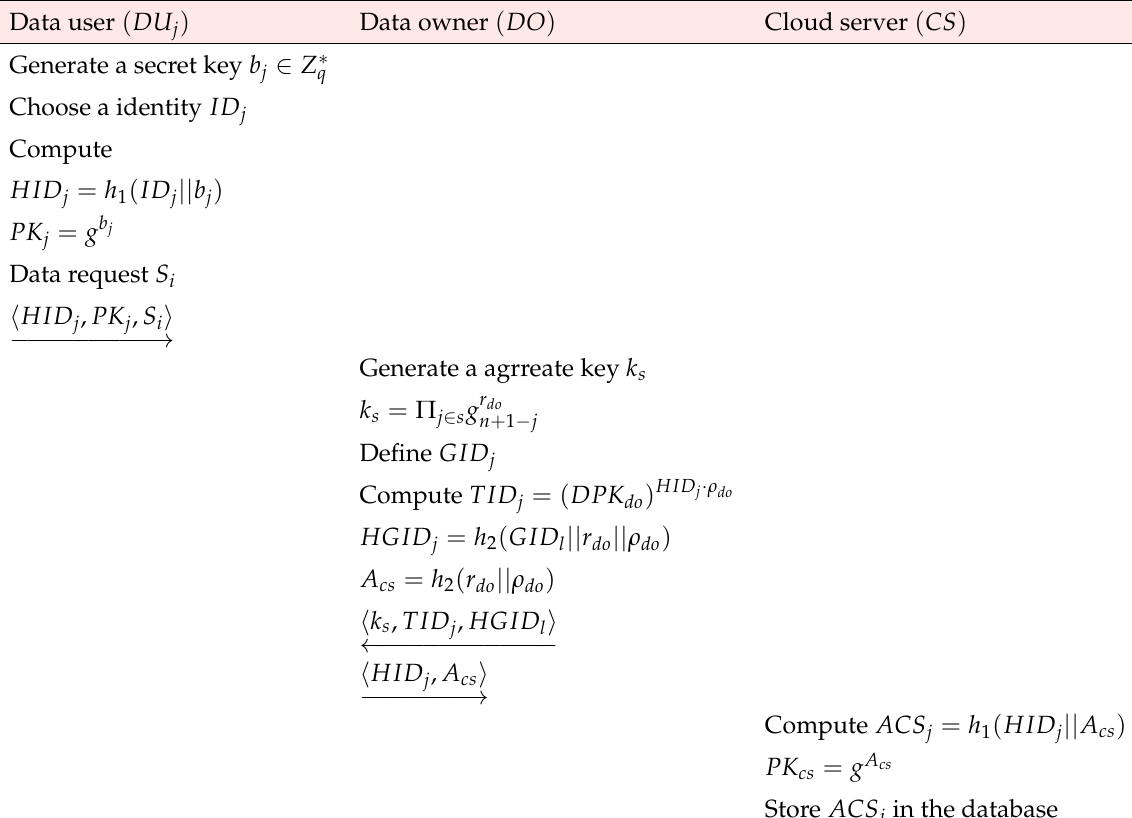
Figure 4. Data request